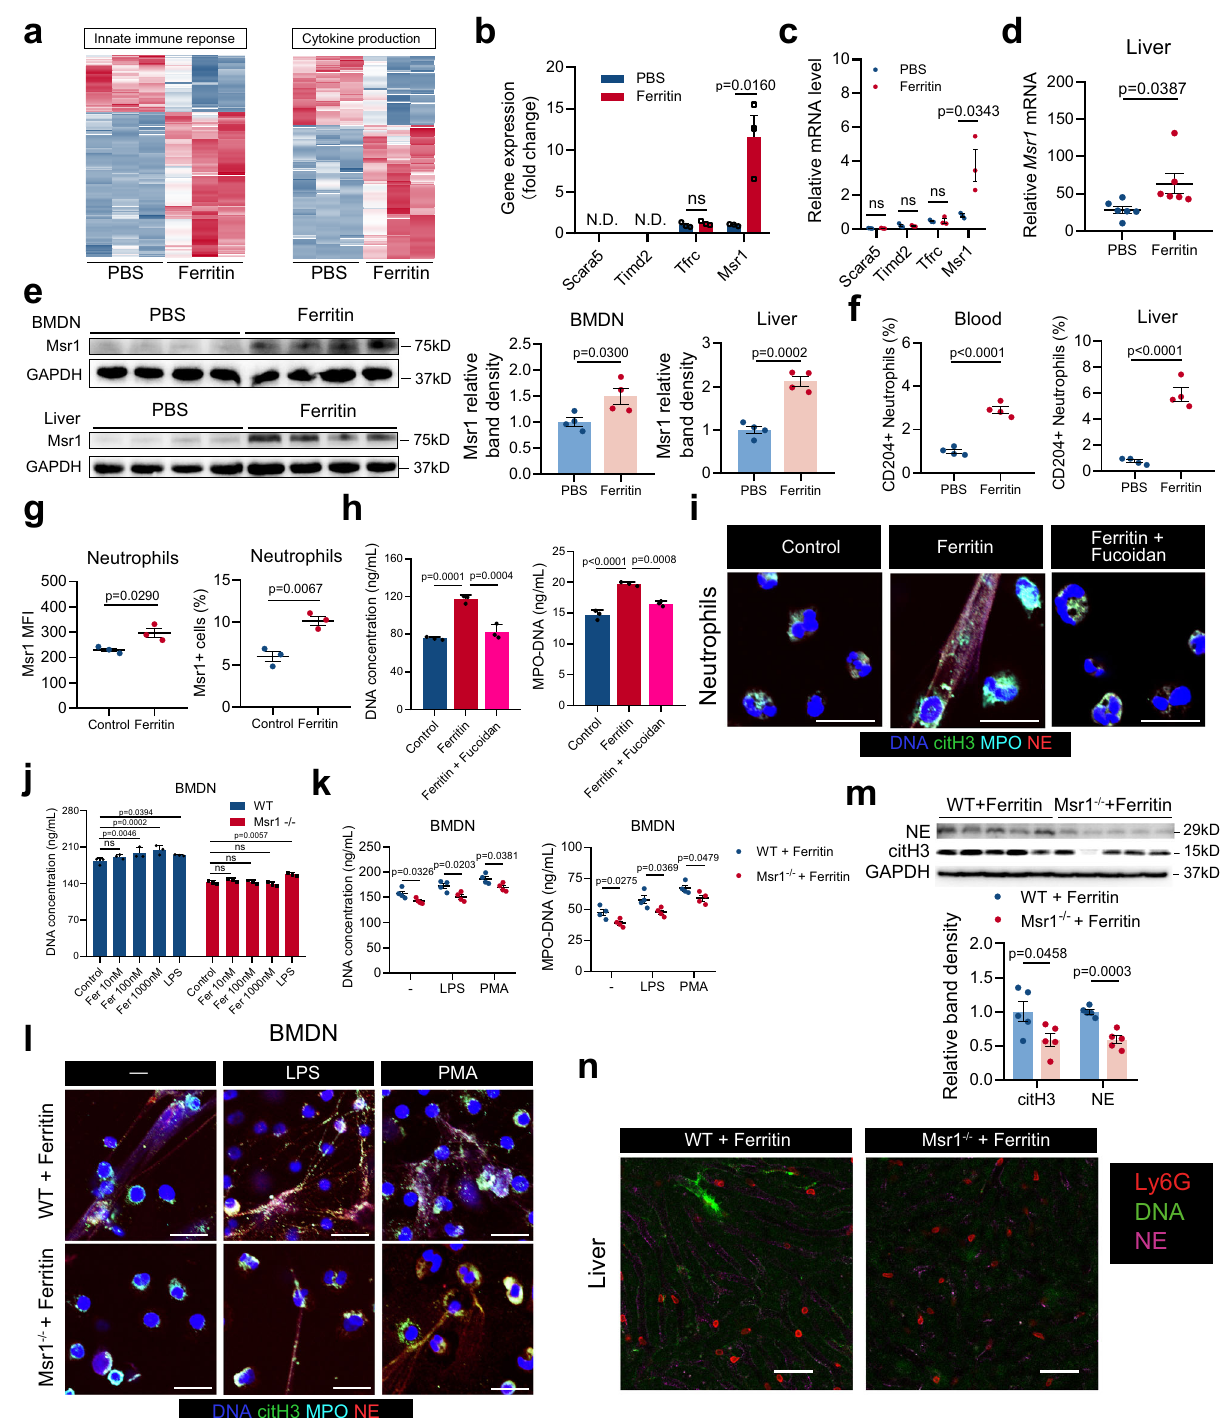
5mM EDTA. Cell-free DNA and MPO-DNA complex in the supernatants wasquanti fi edbyPicoGreen.ForBMDNs,NETformationwascon fi rmed by visualization using 0.3 μ M SYTOX green (S7020, Invitrogen,